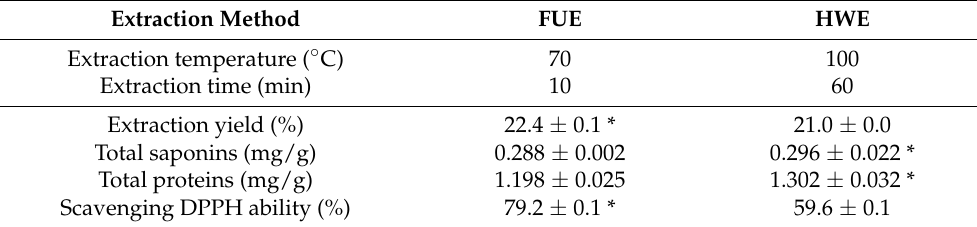
Table 1. Effect of focused ultrasonic extraction (FUE) and hot water extraction (HWE) on yield, active components, and antioxidant activity of wild bitter gourd. Extraction Method FUE HWE Extraction temperature ( ◦ C) 70 100 Extraction time (min) 10 60 Extraction yield (%) 22.4 ± 0.1 * 21.0 ± 0.0 Total saponins (mg/g) 0.288 ± 0.002 0.296 ± 0.022 * Total proteins (mg/g) 1.198 ± 0.025 1.302 ± 0.032 * Scavenging DPPH ability (%) 79.2 ± 0.1 * 59.6 ±